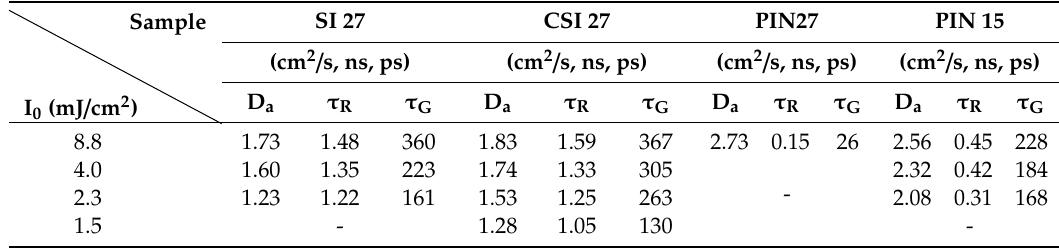
Figure 5. FWM decay spectra with di ff erent excitation powers on ( a ) SI27, ( b ) CSI27, ( c ) PIN15, and PIN27, with the excitation powers of 8.8, 4.0, 2.3, and 1.5 mJ / cm 2 , respectively. Table 2. Carrier lifetime τ R (ps) and di ff usion coe ffi cient D (cm 2 / s) in InGaN layers grown with di ff erent In concentrations (SI27, CSI27, PIN27, and PIN15).